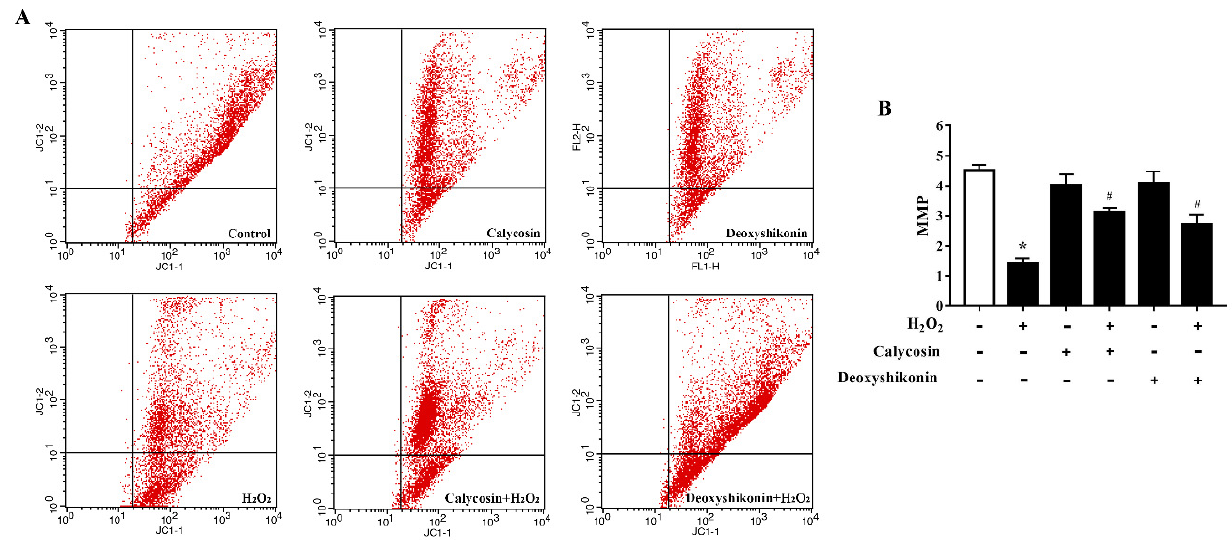
Figure 5. Effects of the hit compounds on H 2 O 2 -induced mitochondrial function reduction in IPEC-J2 cells. IPEC-J2 cells were pretreated, and not pretreated, with calycosin or deoxyshikonin for 24 h, then with 1000 µ M H 2 O 2 incubation for 4 h. Nontreated cells served as a control. ( A ) Flow-cytometric analysis of the mitochondrial membrane potential (MMP). ( B ) Quantification of the MMP based on flow cytometry data. Data represent the mean ± SEM of three independent experiments. Differences between two groups were determined using Student’s t -tests. * p < 0.05 vs. nontreated control cells; # p < 0.05 vs. H 2 O 2 -treated cells.